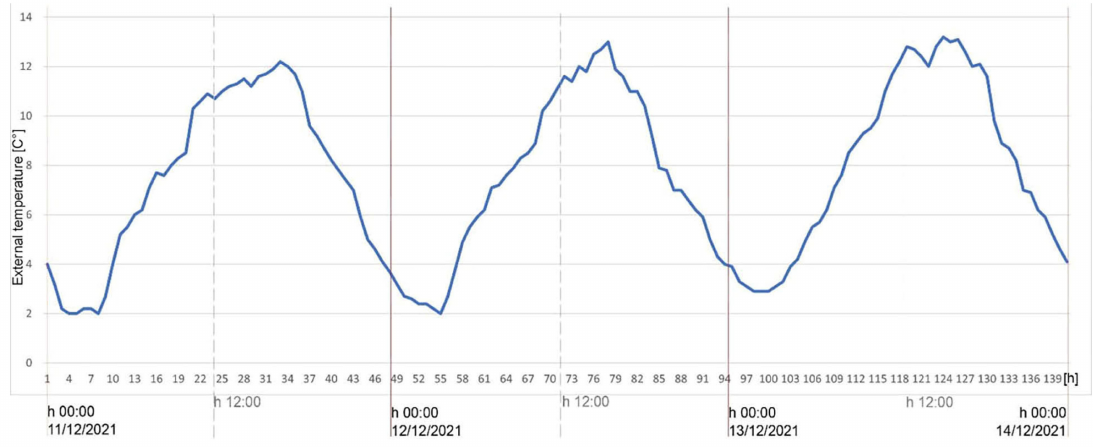
Figure 13. External temperature diagram as a function of time: ante operam.